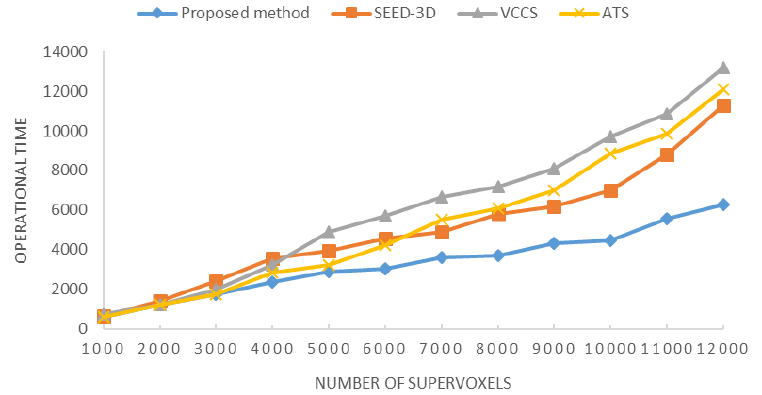
Figure 11. Relationship between the operation time and the supervoxel number.